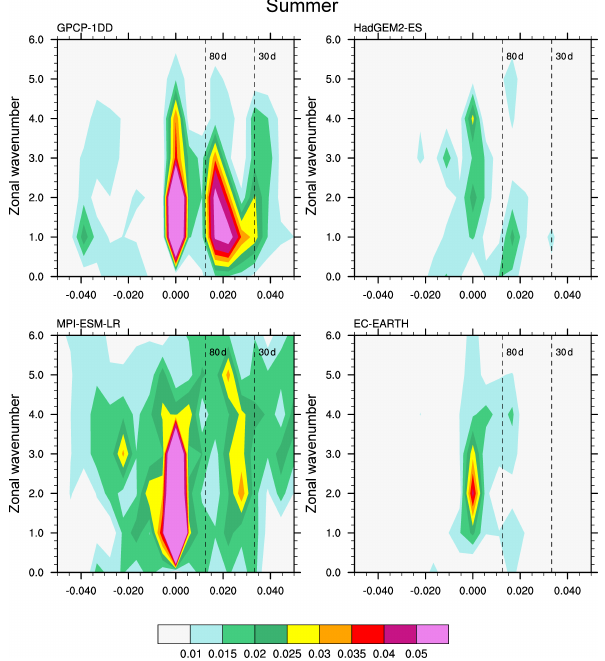
Figure 10. May–October wavenumber-frequency spectra of 10 ◦ S–10 ◦ N averaged precipitation (mm 2 day − 2 ) for